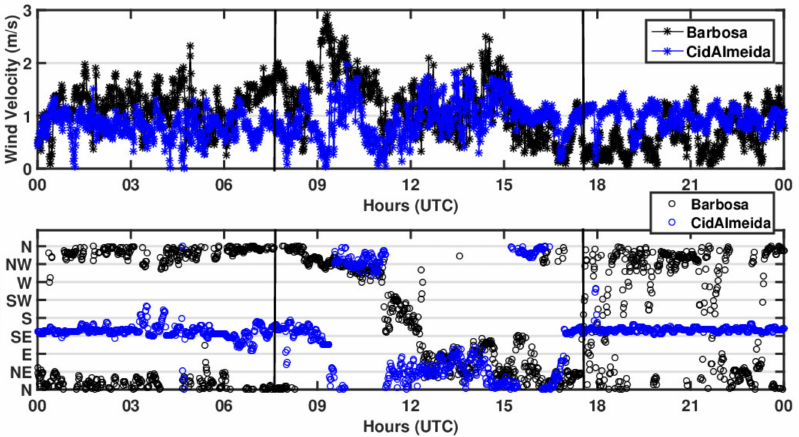
Figure 14. Wind speed ( Upper panel ) and wind direction ( lower panel ) in Alqueva on 1 January 2019. Grey vertical lines indicate the sunrise and